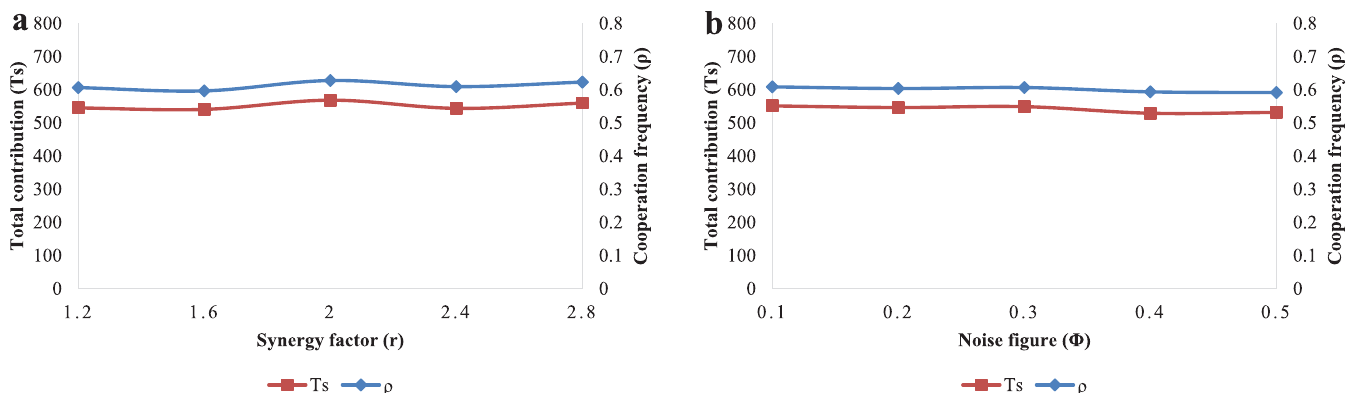
Fig 12. The equilibrium results of total contributions Ts and cooperation frequency ρ . (a) The equilibrium results of total contributions and cooperation frequency for different synergy factors ( r = 1.2, 1.6, 2, 2.4, 2.8). (b) The equilibrium results of total contributions and cooperation frequency for different noise figure ( ϕ = 0.1, 0.2, 0.3, 0.4,